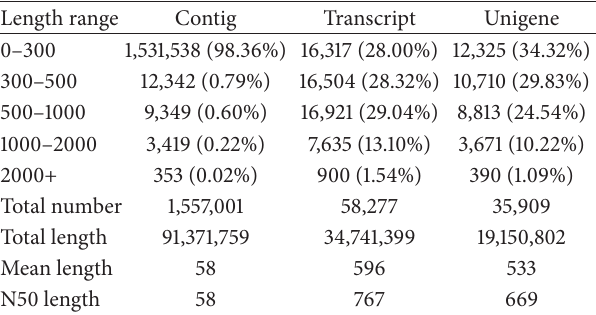
Table 1: Length distribution of assembled contigs, transcripts, and unigenes from Weiduoli and HVB-3.